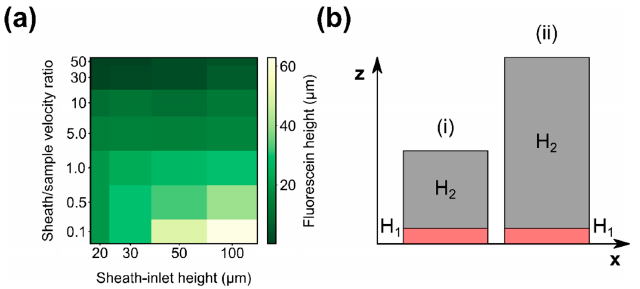
Figure 2. ( a ) Parametric sweep performed in COMSOL Multiphysics ® . Flow velocity ratio (y-axis) refers to the ratio between sheath fluid velocity and sample flow velocity. Device height (x-axis) refers to the total height of the device, assuming a constant sample inlet height of 10 μ m. Sample height (color scale) refers to the maximum distance between coverslip and sample. Log–log scale has been used to better resolve the areas of interest; ( b ) Cross sections of two-layer device geometries tested, where H 1 is the height of the bottom layer and H 2 is the height of the top layer: (i) H 1 = 10 μ m, H 2 = 50 μ m, (ii) H 1 = 10 μ m, H 2 = 110 μ m device.